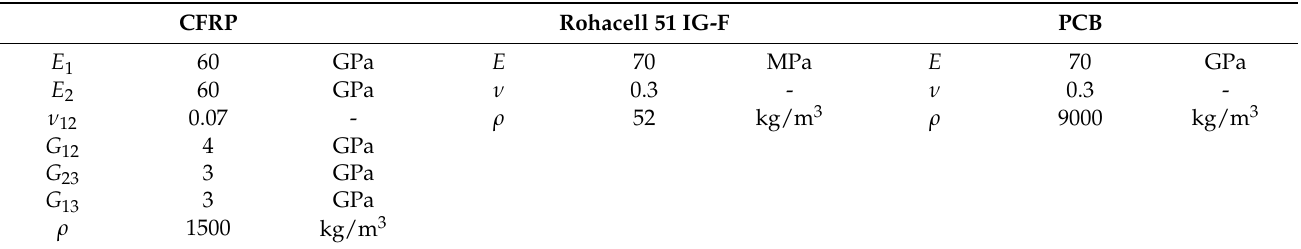
Table 3. Mechanical properties used for antenna simulation.